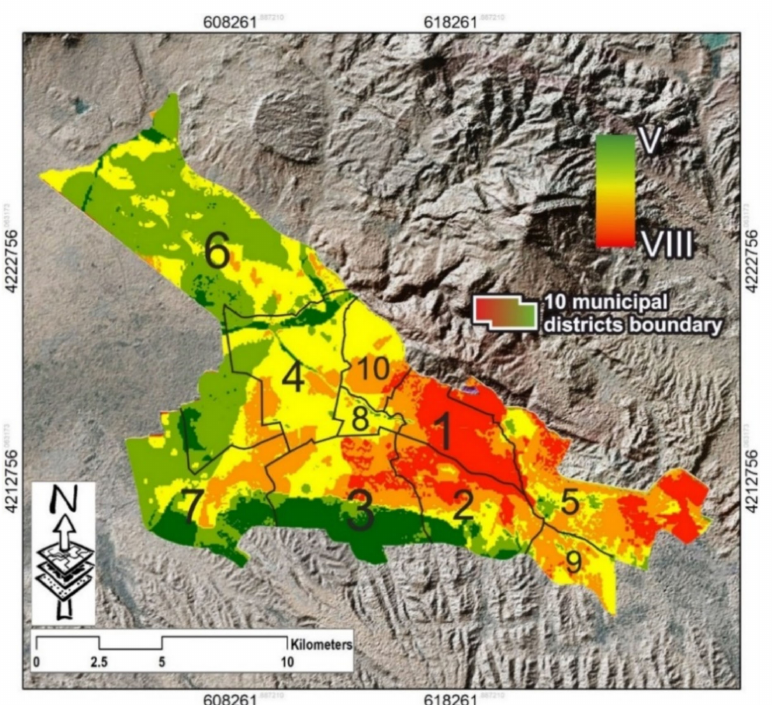
Figure 21. Ground shaking map illustrating the regional extent of the intensity that can be expected from a magnitude 7.4 (1780) earthquake on the North Tabriz